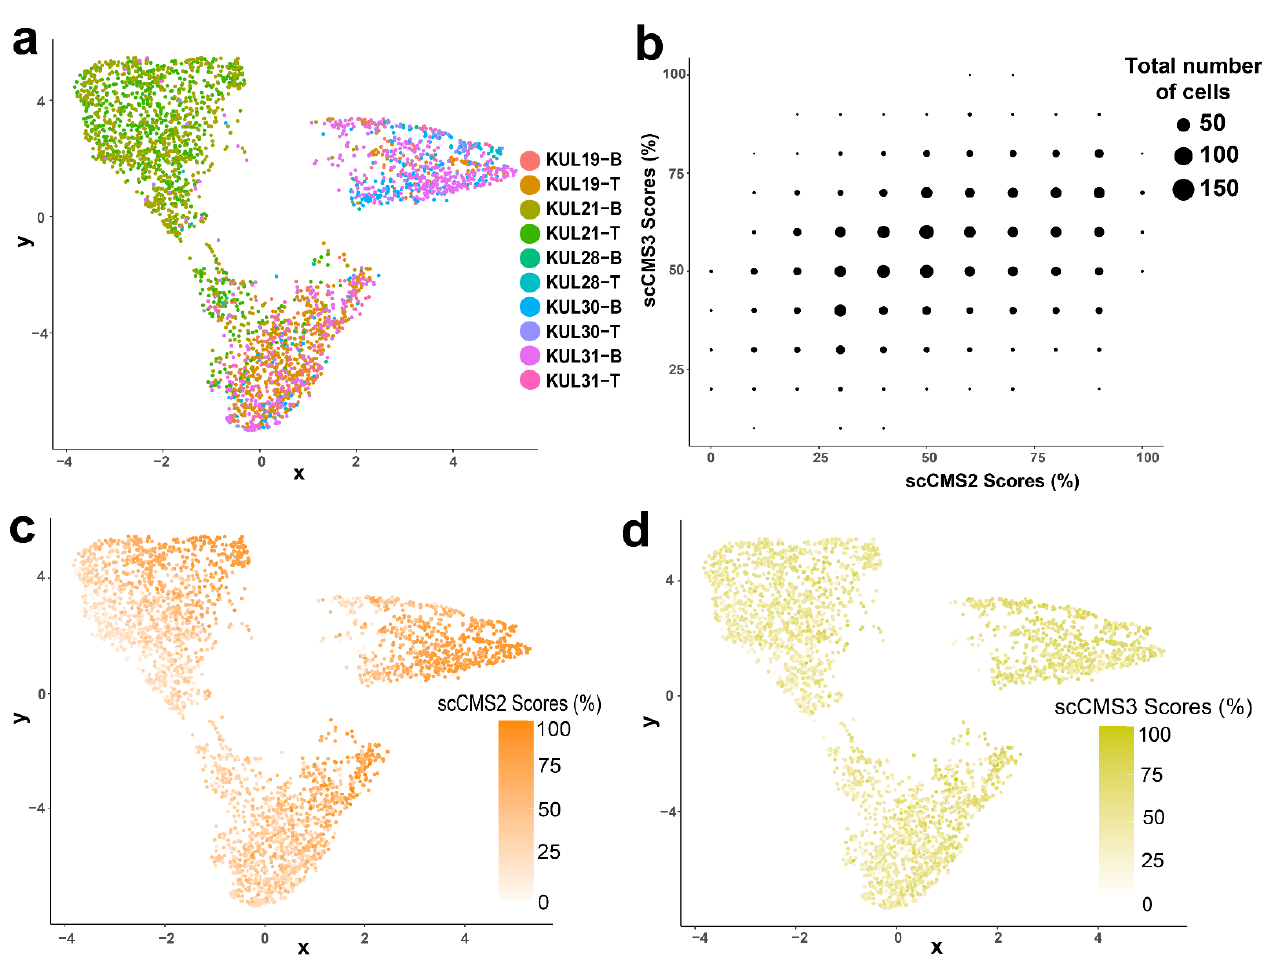
Figure 5. UMAP plots of scCMS2 and scCMS3 scores in epithelial cells clusters. Same UMAP projection as Figure 4e,f but now colored by ( a ) tumor sample ids. ( b ) Scatter plot showing scCMS2 and scCMS2 scores of each epithelial cells. UMAP plots of ( c ) scCMS2 and ( d ) scCMS3 scores of individual epithelial cells.